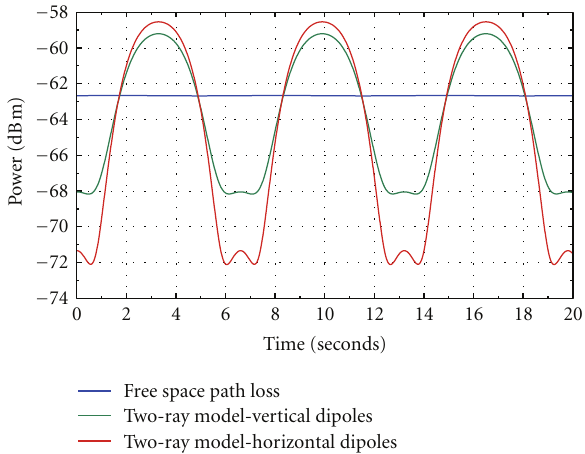
Figure 8: Received power versus time, sea-state 5, ship motions in the incidence plane.